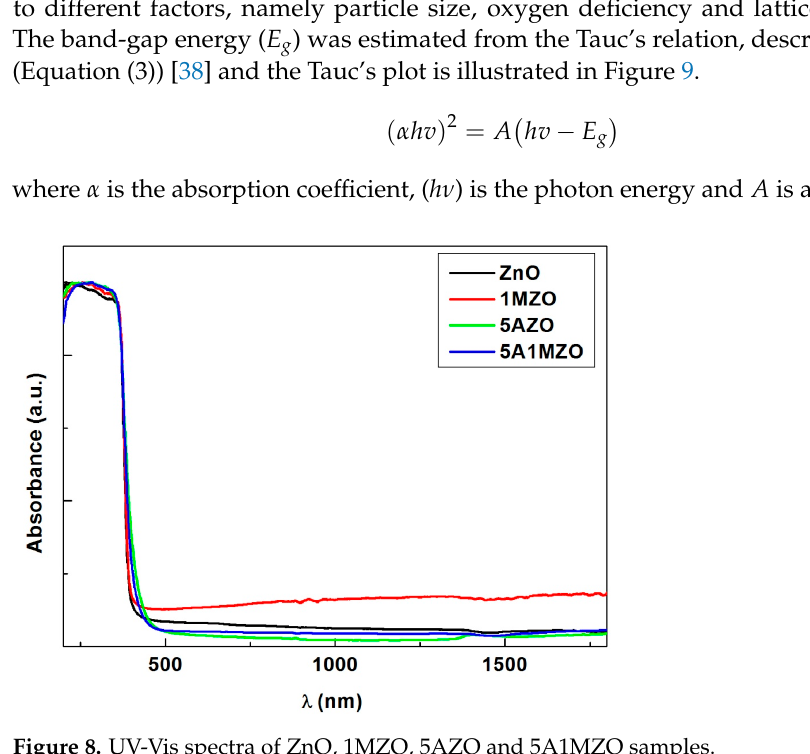
Figure 8. UV-Vis spectra of ZnO, 1MZO, 5AZO and 5A1MZO samples.